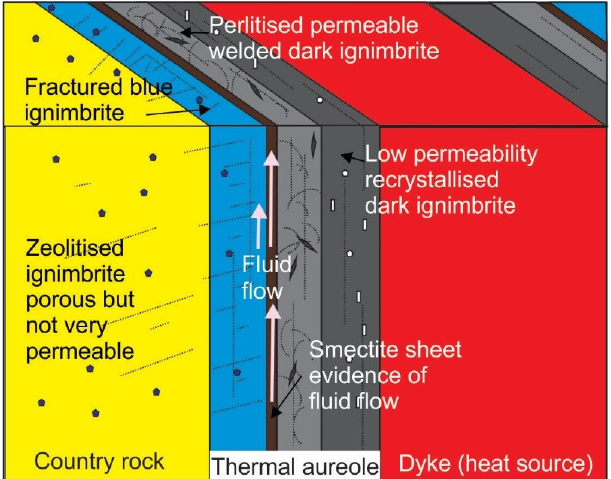
Figure 9: Conceptual diagram of the dyke at Hvítserkur mountain (East Iceland) and its thermal aureole. Also provided is our interpretation of the fluid flow zone. The width of the thermal aureole is about 3